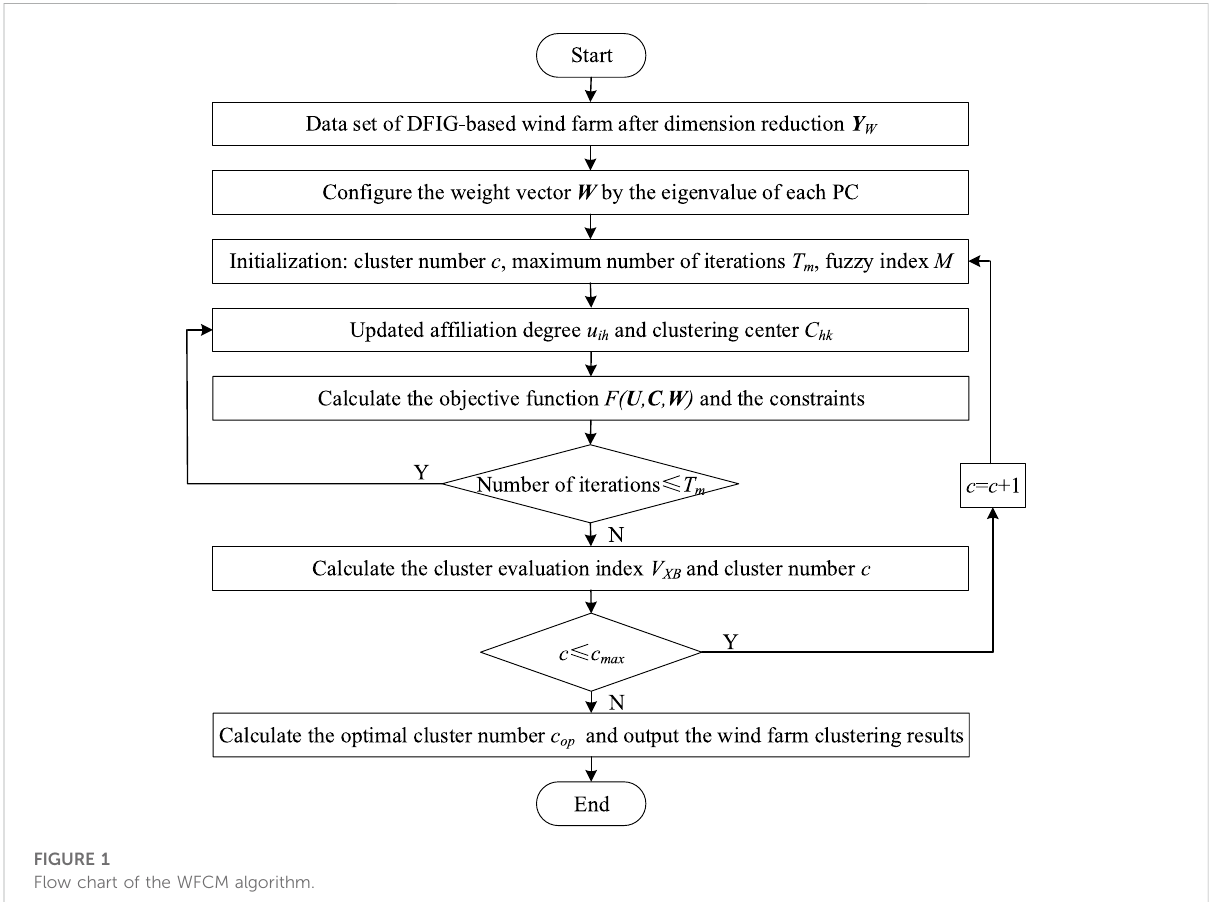
FIGURE 1 Flow chart of the WFCM